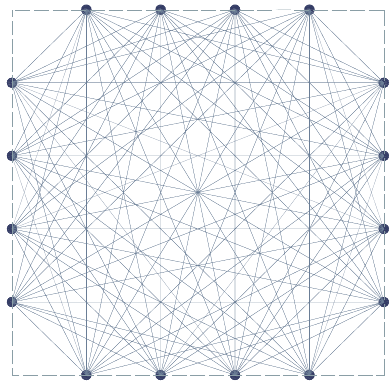
Figure 7. The 96 signal paths for the PZT sensors layout.